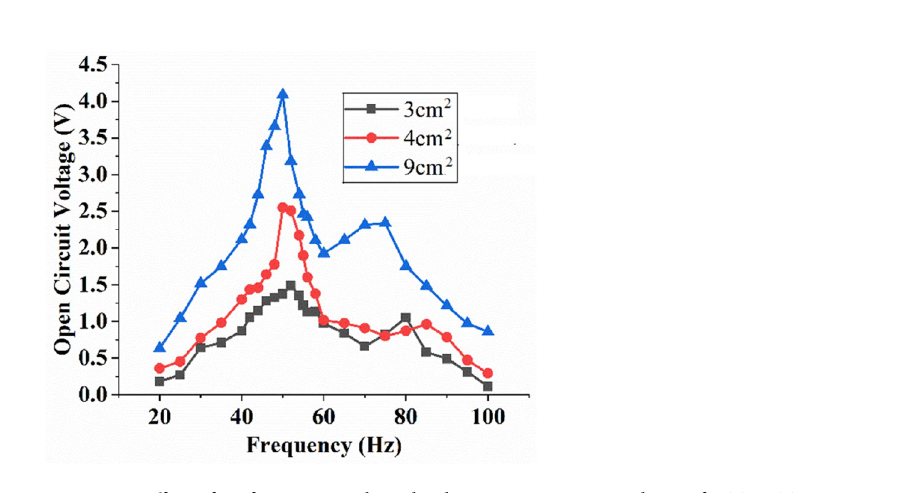
Figure 6. Effect of surface area on the triboelectric open-circuit voltage of